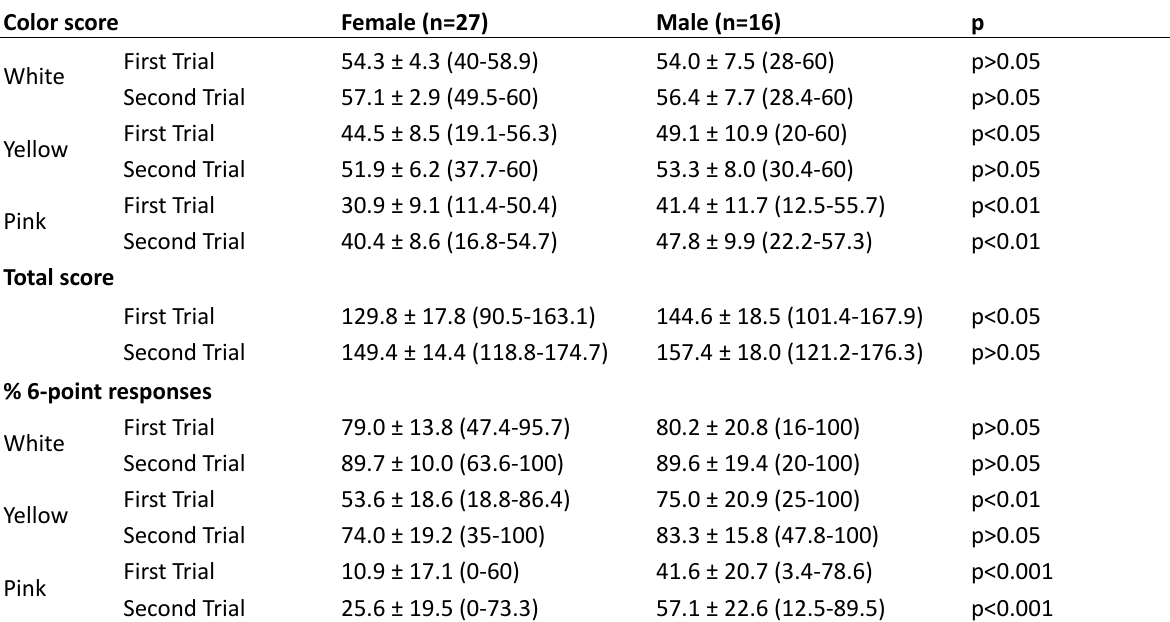
Table 6. Comparison of gender with regard to data obtained in IBSAP.